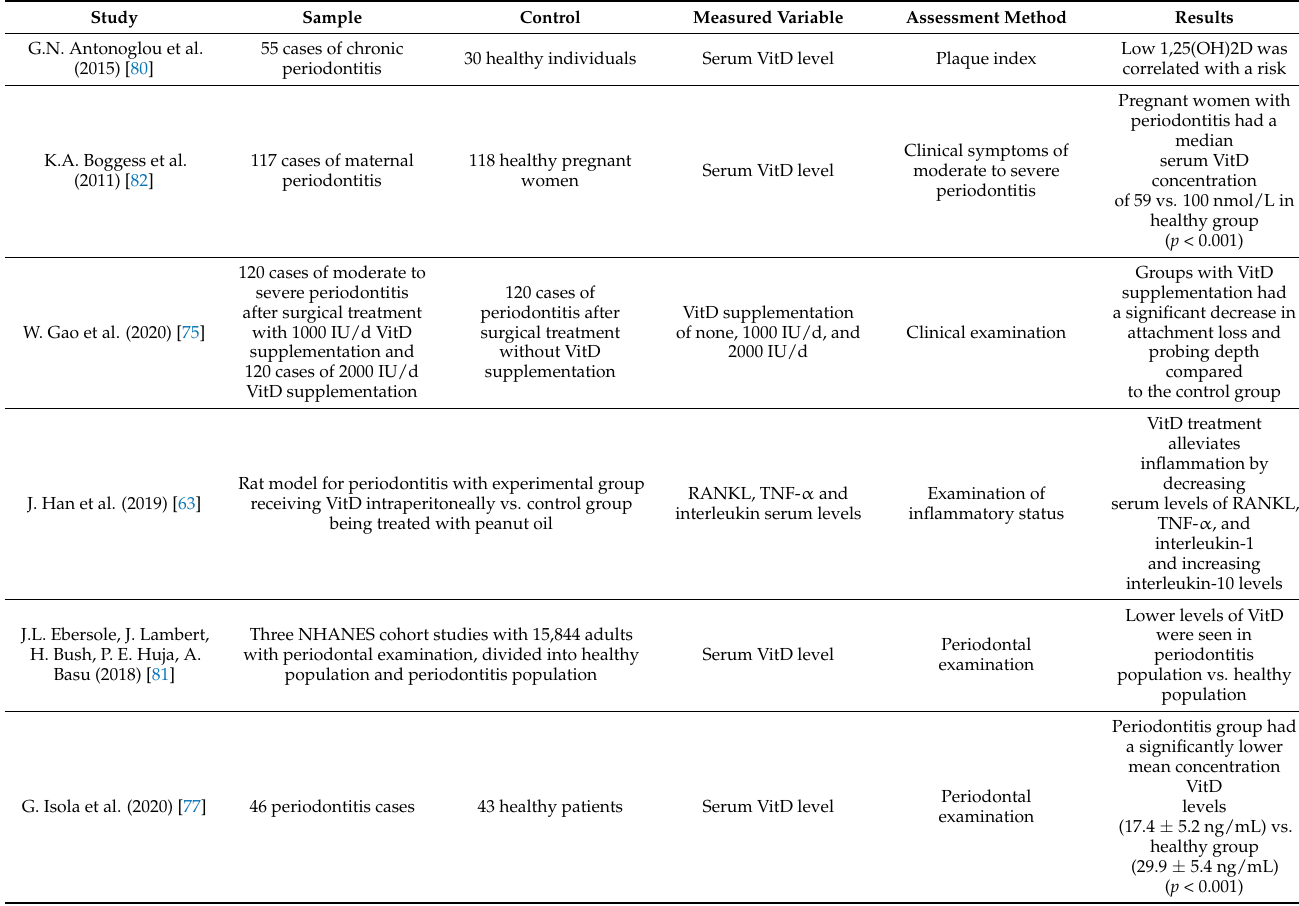
Table 2. A summary of the most important studies on the effects of VitD on periodontal